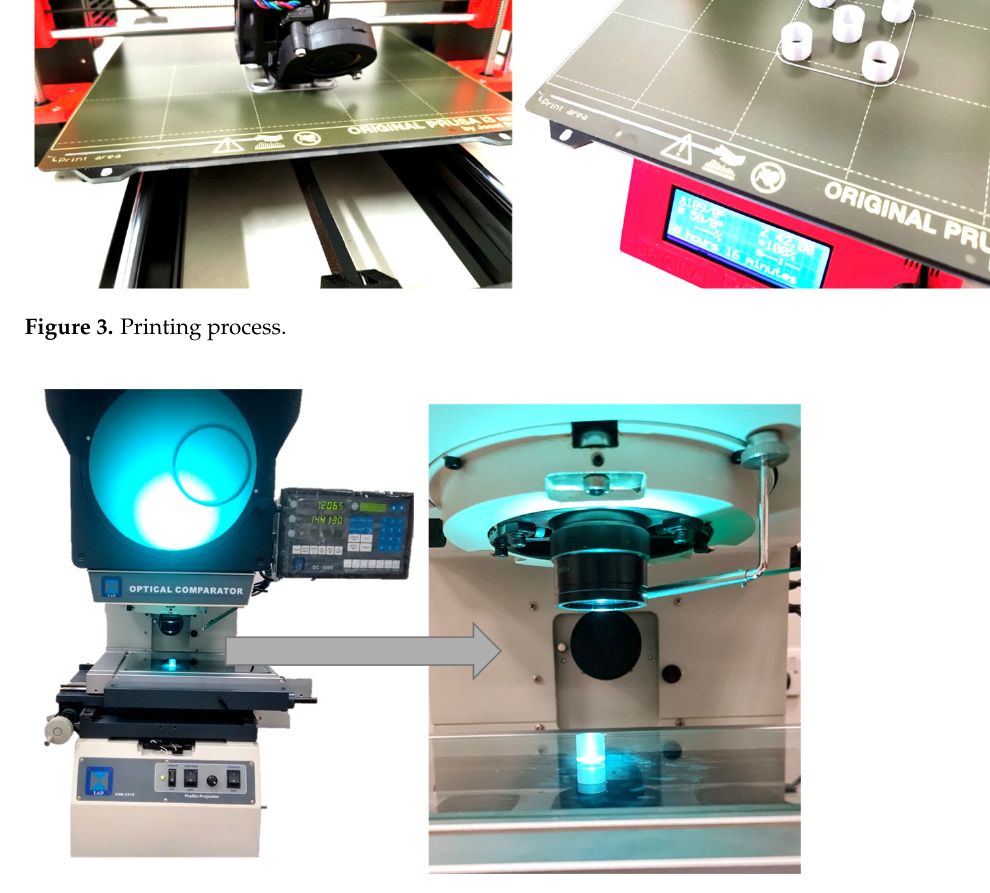
Figure 3. Printing process.